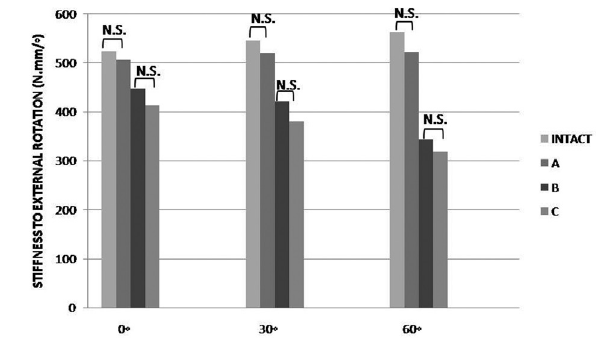
Figure 7 - Comparison of stiffness to external rotation among groups with 0, 30 and 60 degrees of flexion. All values were significant, except where notated N.S. (not